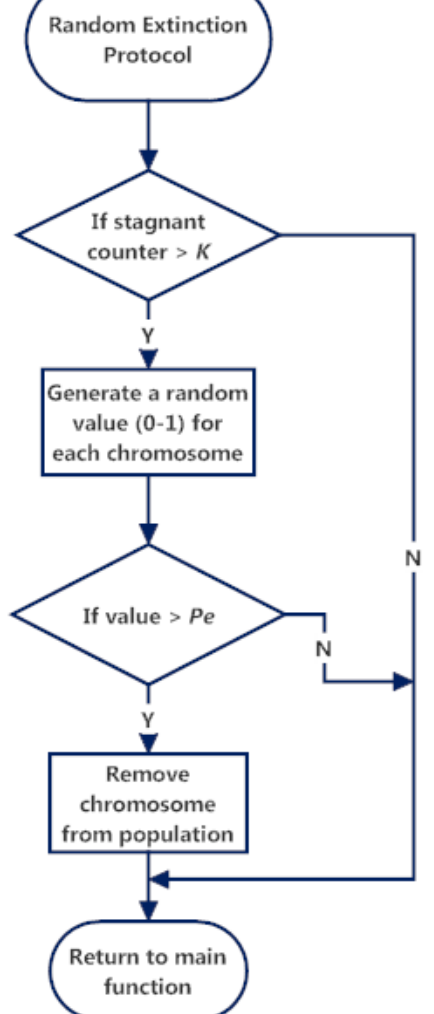
Figure 3. Flowchart of Random Extinction